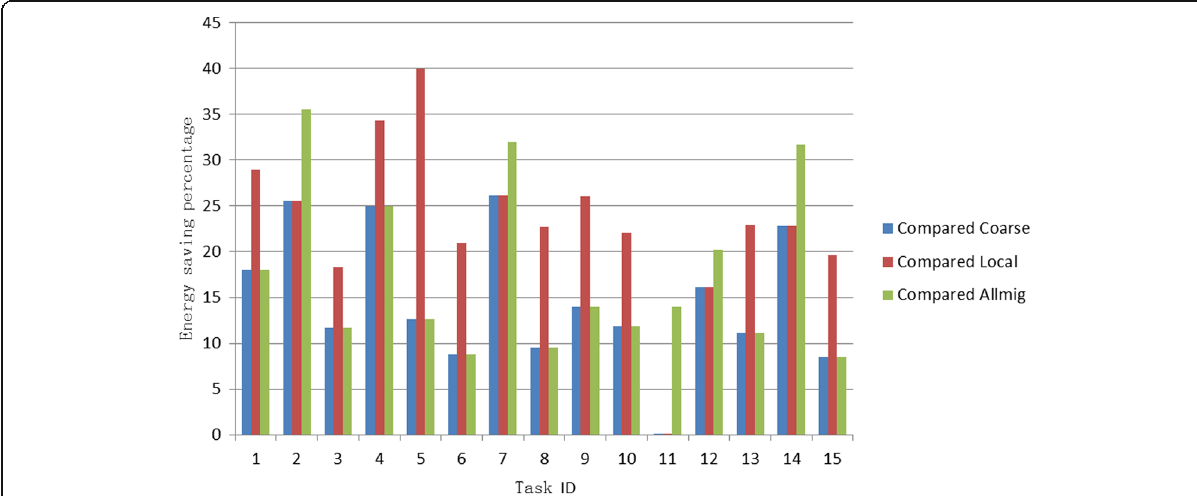
Fig. 6 The comparison of energy conservation between FGMBGA and the other three strategies. It shows the percentage of energy-conserving energy consumption compared with the other three strategies for the fine-grained task migration strategy based on genetic algorithms